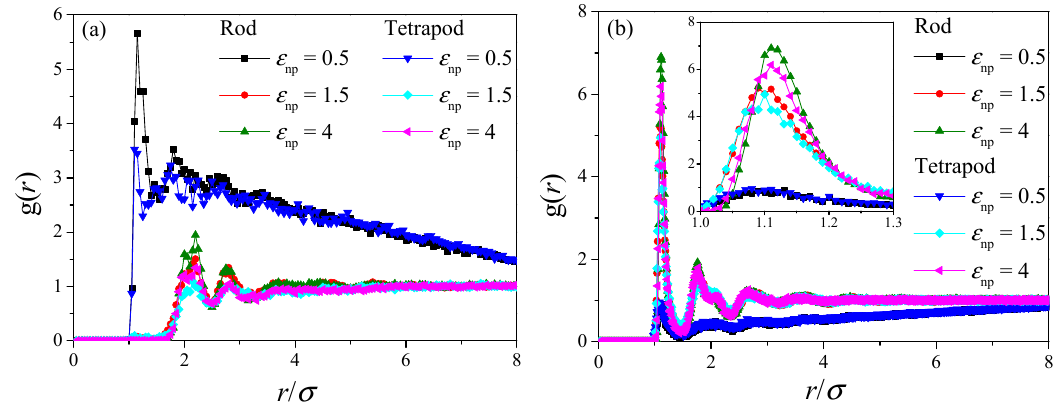
Figure 8. The radial distribution function (RDF) of rod and tetrapod nanocomposites with different polymer-nanoparticle interactions: ( a ) inter-nanoparticle RDF; ( b ) RDF between nanoparticle and polymer matrix; the inset shows the partial enlarged view of the peak.